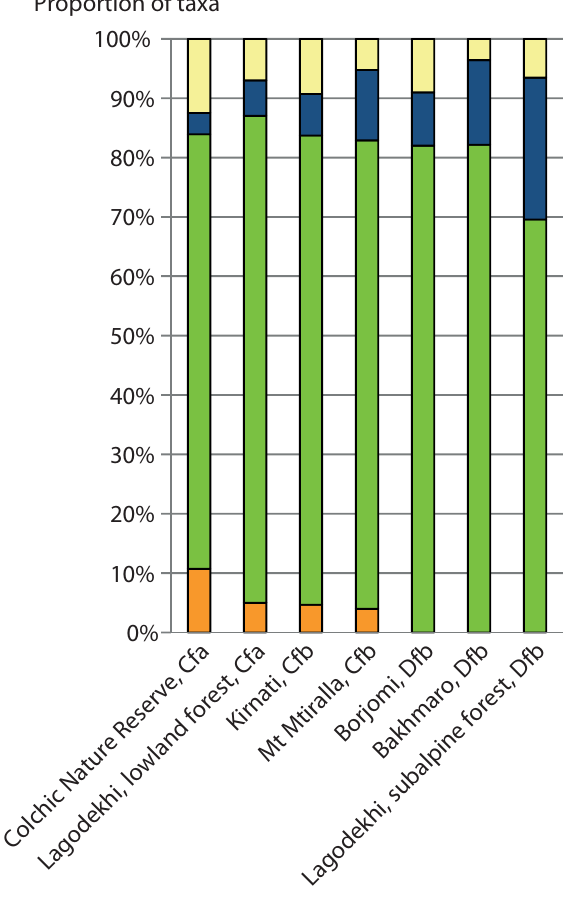
Fig. 8. Proportion of elements ascribed to major vegetation types in modern forest communities of humid temperate Georgia, Tran- scaucasia. Elements are categorized as meridio-nemoral (orange), nemoral (green), boreal (dark blue), and generalists (yellow) based on their specific Köppen